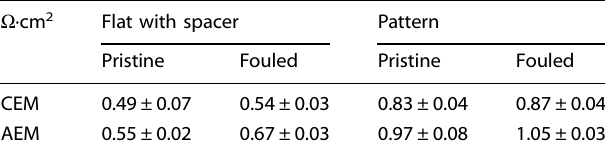
Table 1. Change of membrane resistance before and after continuous reverse electrodialysis operation. The values with standard deviations were measured in triplicate at least. Ω ·cm